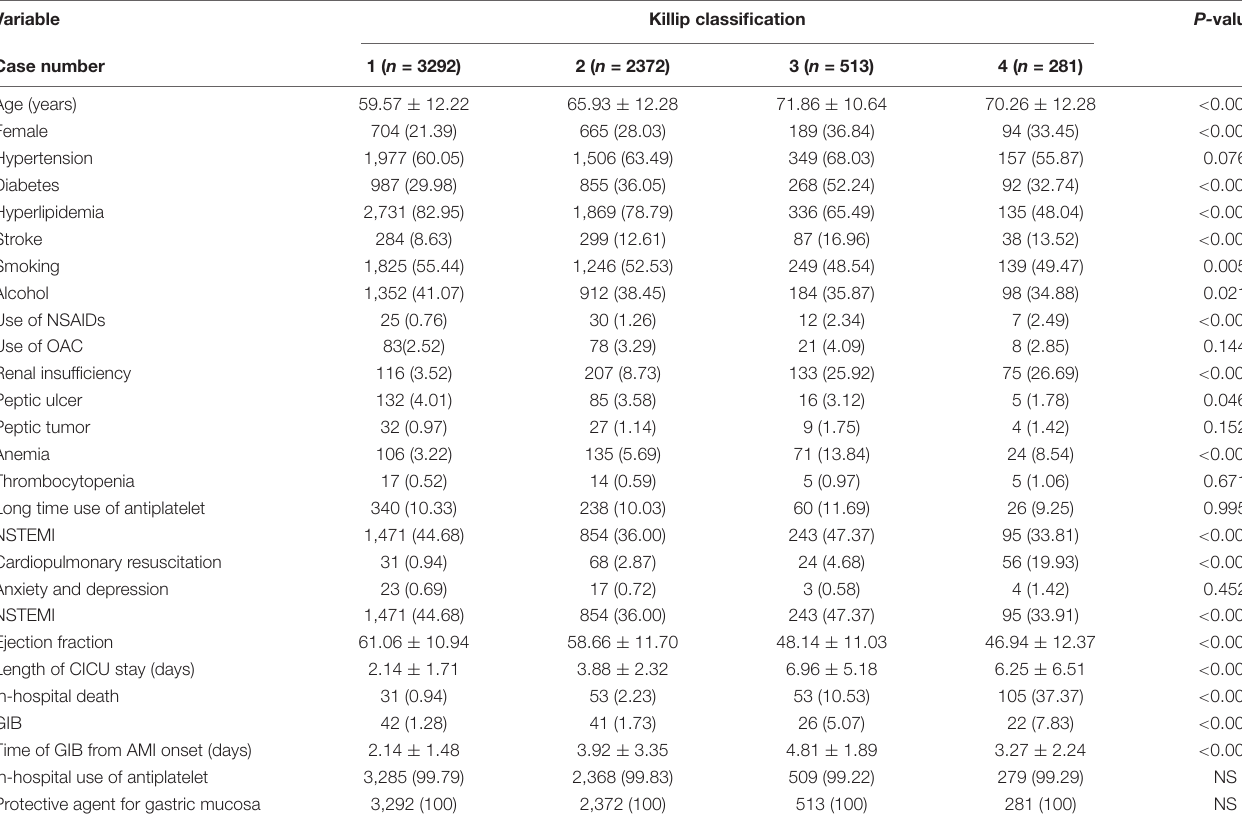
TABLE 2 | Patient characteristics and GIB in groups